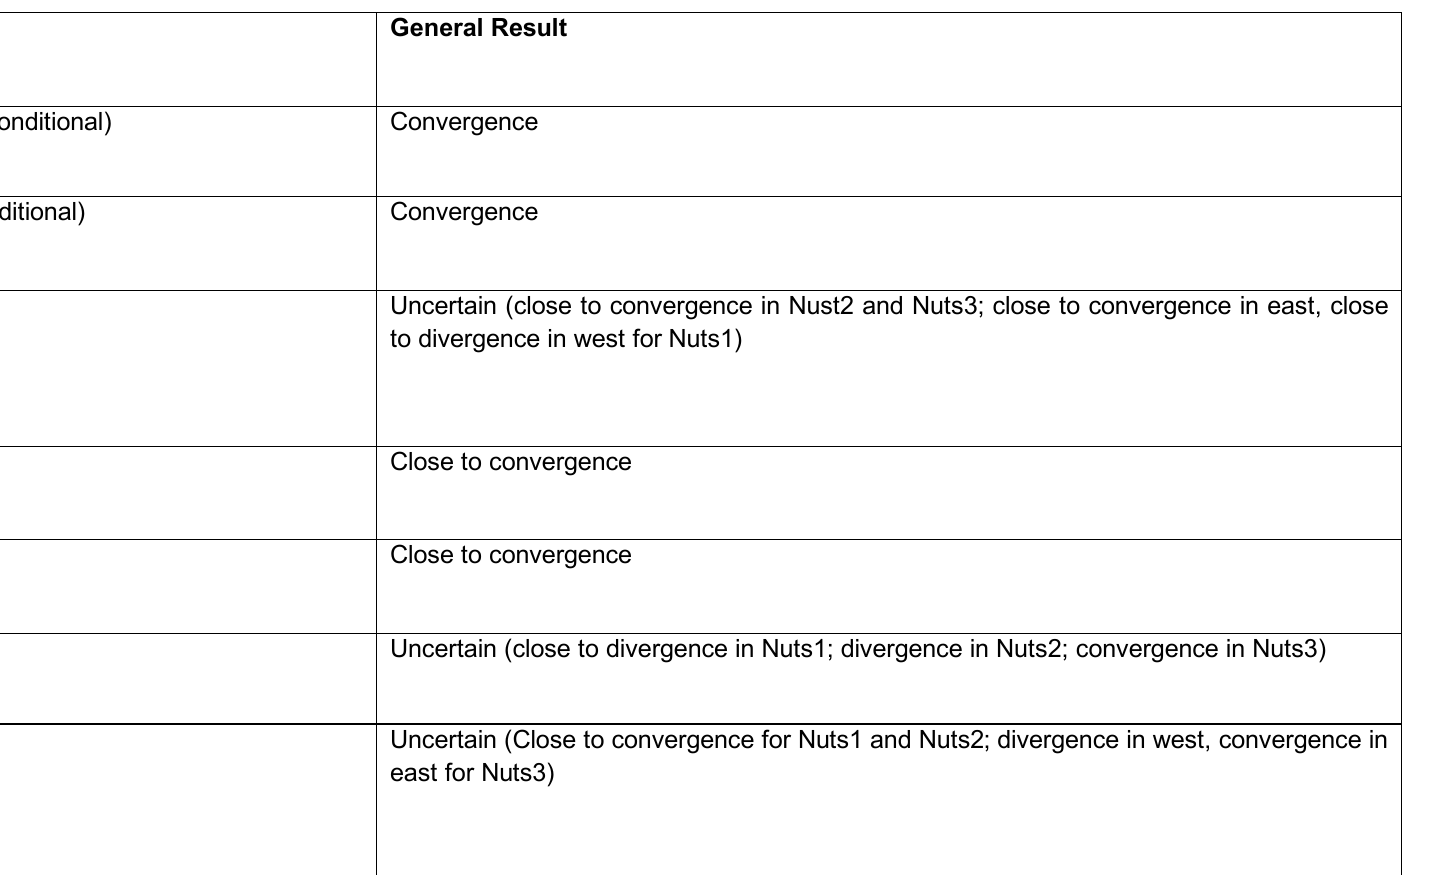
Table 8: General